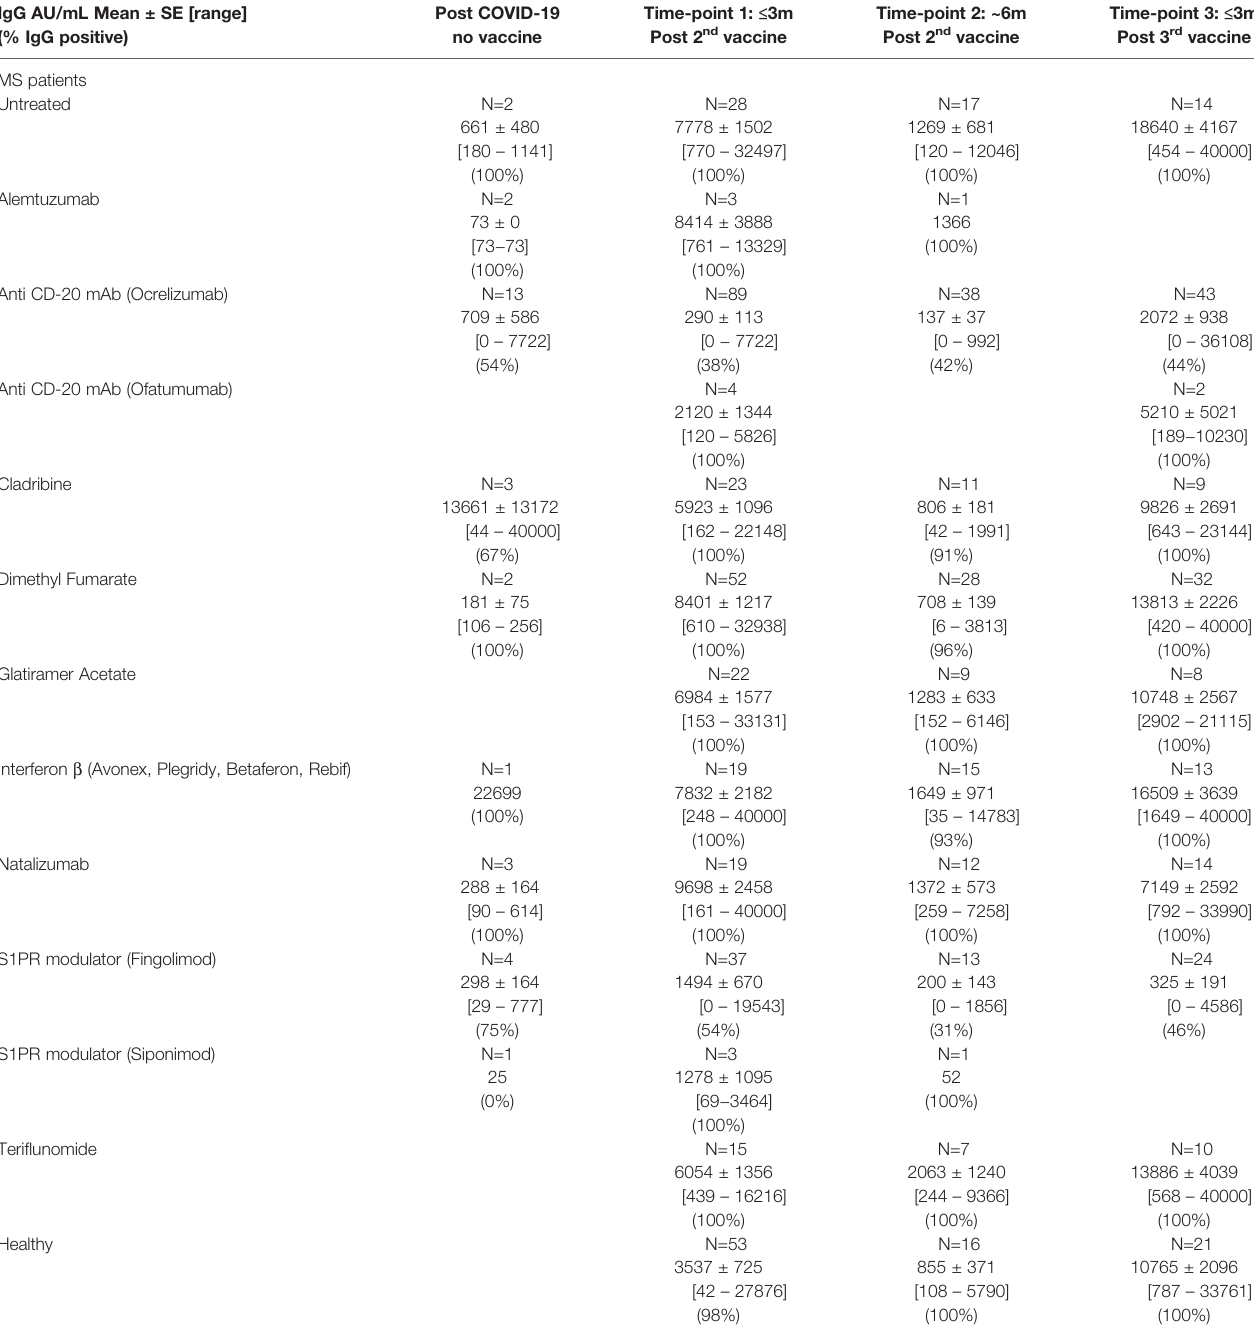
TABLE 2 | IgG index following SARS-CoV-2 vaccination or COVID-19. IgG AU/mL Mean ± SE [range] (% IgG